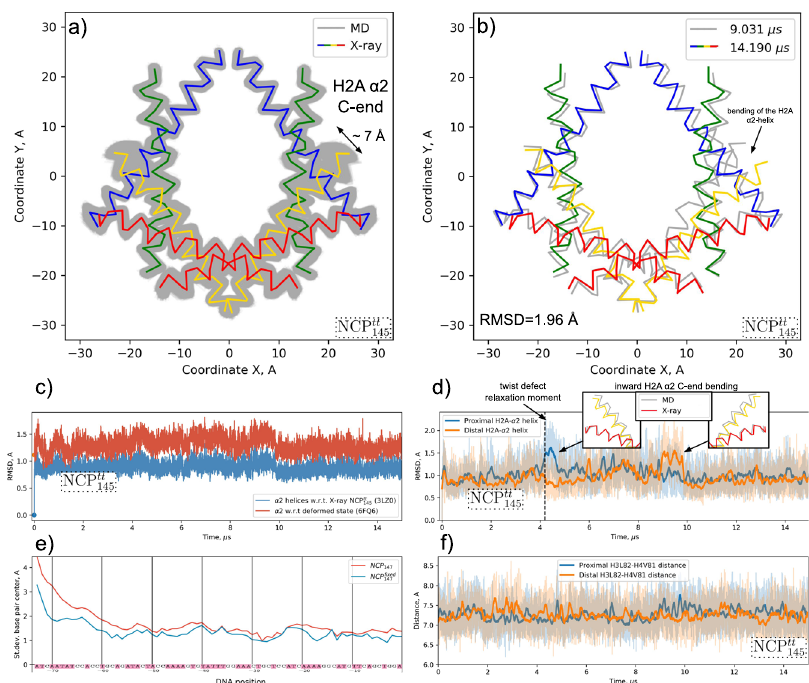
Fig. 8 Plasticity of the histone octamer in NCP and its effects on the nucleosomal DNA dynamics. a – d Present data for NCP tt 145 simulations. a 2D projections of histone α 2-helices ’ C α -atoms ( α 2-C α -atoms) on the plane perpendicular to the superhelical axis for MD snapshots vs. X-ray structure. b Same as ( a ), but for the two MD snapshots with the maximum RMSD as measured by positions of α 2-C α -atoms. c Variation of RMSD with simulation time measured for α 2-C α -atoms positions with respect to the initial X-ray structure and a cryo-EM structure of a “ squeezed ” NCP (PDB ID 6FQ6) 25 . d RMSD calculated for C α -atoms of the H2A α 2-helices as a function of simulation time. Insets show inward bending of the helix associated with higher average RMSD. e Average DNA fl uctuations for one half of the nucleosomal DNA compared for NCP147 simulations (<8 µ s) and NCP fi xed147 simulations with restrained histone folds. f Distance between C α -atoms of H3L82 and H3V81 residues. Thick lines in ( d ) and ( f ) show signal smoothed with Savitzky-Golay fi